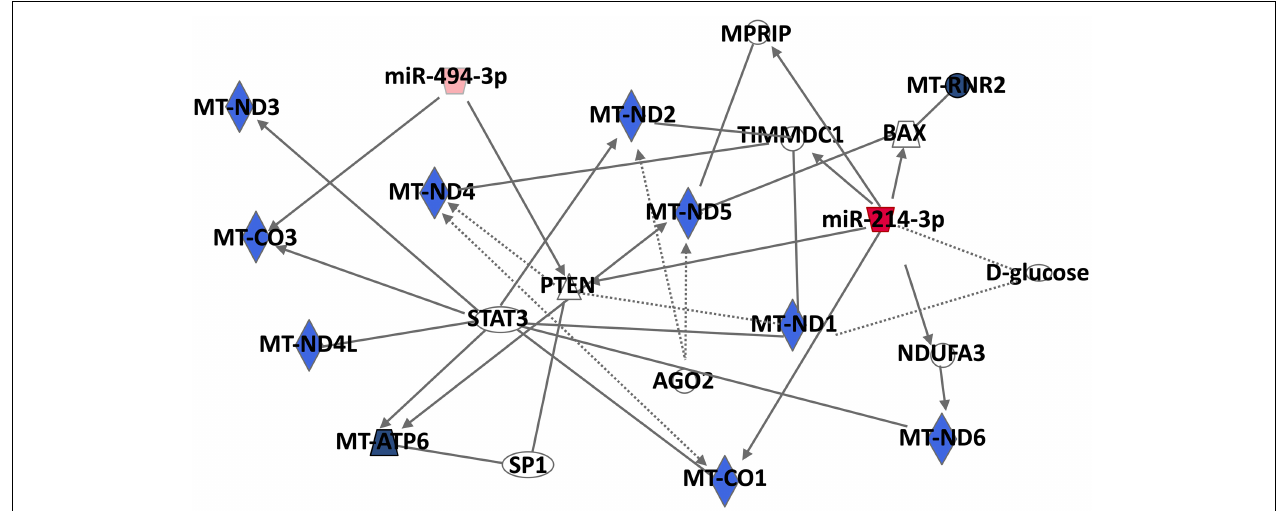
FIGURE 3 | Mt-mRNA-miRNA networks generated with Ingenuity Pathway Analysis (IPA) for the two most described MitomiRs, miR-494, and miR-214. IPA analysis was performed to investigate genes associated with Mt-mRNAs. Filters were set to include either putative, experimentally observed or high-confidence-predicted miRNA-mRNA interaction partners. MiRNAs were colored in red depending on whether they were upregulated in mitochondria fractions following macrophage differentiation. The red color intensity corresponds to the fold change in miRNA expression in the mitochondria-enriched fraction of PMA-differentiated THP-1 macrophages compared to untreated